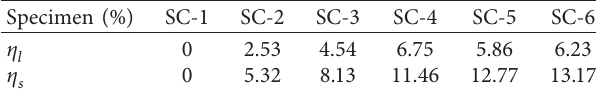
Table 5: Corrosion ratios of the steel